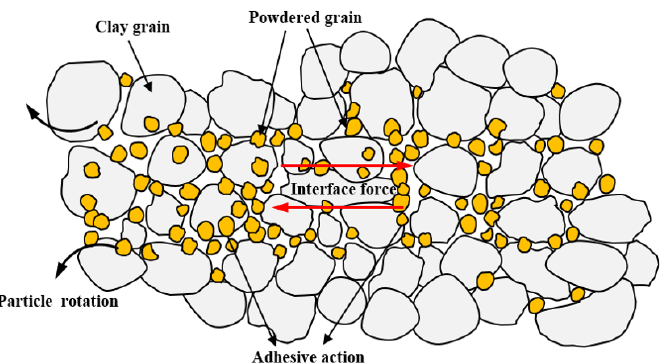
Figure 9. Schematic diagram of the interface mechanical interaction between soil particles.